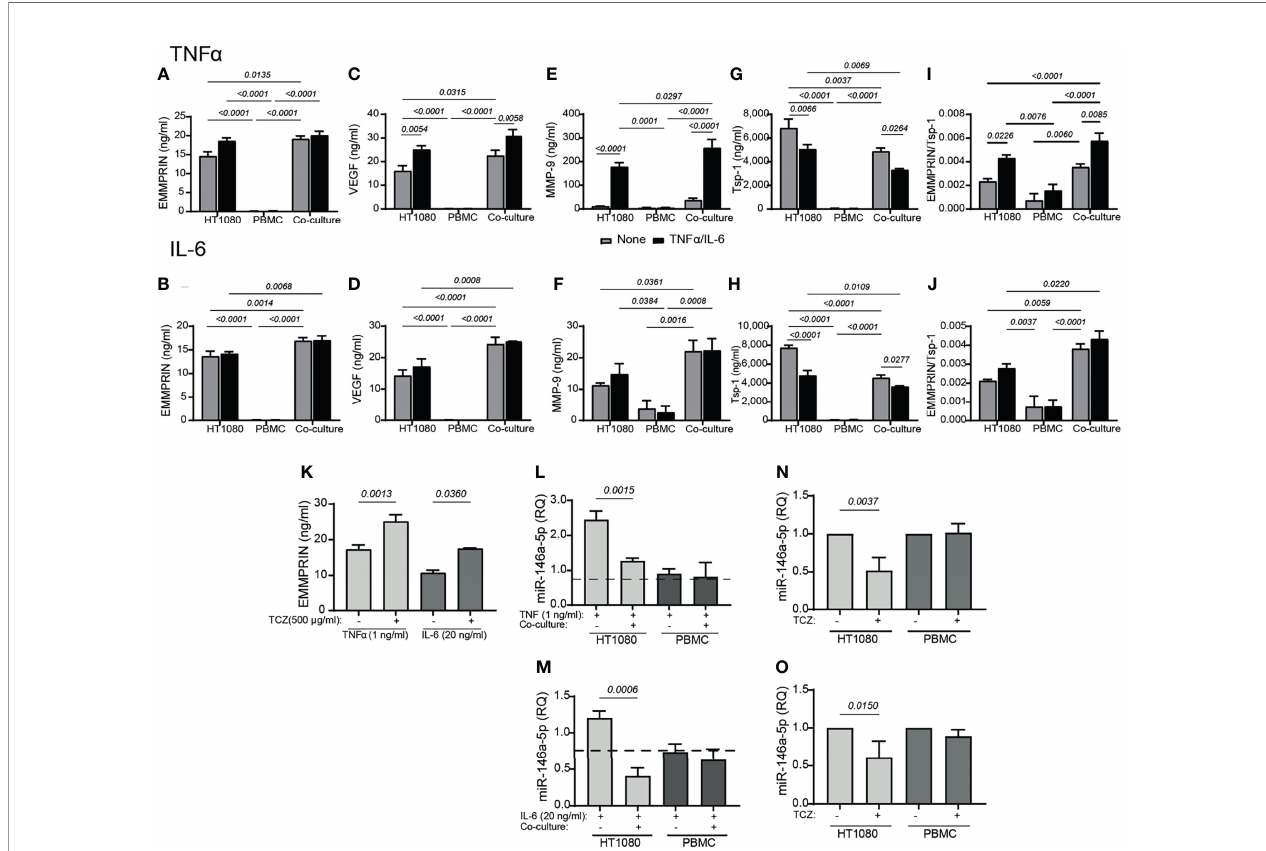
FIGURE 9 | Primary monocyte-enriched PBMC co-cultured with HT1080 fi broblasts enhance the secretion of EMMPRIN, VEGF and MMP-9, and TCZ enhances EMMPRIN and reduces miR-146a-5p expression. HT1080 cells (8x10 4 cells/well in 650 m L) were cultured alone or in co-culture with monocyte-enriched PBMCs at a ratio of 1:1, in the absence or presence of TNF a (1ng/mL, top panel) or IL-6 (20 ng/ml, lower panel). Supernatants were collected after 48h of incubation and the concentrations of (A, B) EMMPRIN, (C, D) VEGF, (E, F) MMP-9, and (G, H) Tsp-1 were determined by ELISA. (I, J) The EMMPRIN/Tsp-1 ratio was calculated for each repetition. The two-way analysis of variance (ANOVA) test was used to compare multiple groups, followed by the post-hoc Bonferroni ’ s multiple comparison test (n=4-5 in all groups). Co-cultured HT1080 cells and monocyte-enriched PMBC were incubated in the presence or absence of TCZ (500 m g/ml), and (K) their levels of secreted of EMMPRIN were determined. The unpaired student t test was used to compare between groups within each cell line (n=4-5 in each group). Total RNA was extracted from HT1080 or monocyte-enriched PBMC that were co-cultured with or without (L) TNF a (1 ng/ml) or (M) IL-6 (20 ng/ml) for 48 hours, and the expression levels of miR-146a-5p were determined in each of the cell types compared to single cultures without the cytokines (dashed line). The unpaired student t test was used to compare between groups within each cell line. (n=4-5 in each group). Lastly, the effects of TCZ on the expression levels of miR-146a-5p in each cell type in the presence of (N) TNF (1 ng/ml) or (O) IL-6 (20 ng/ml) were determined. The unpaired student t test was used to compare between groups within each cell line. (n=4-5 in each